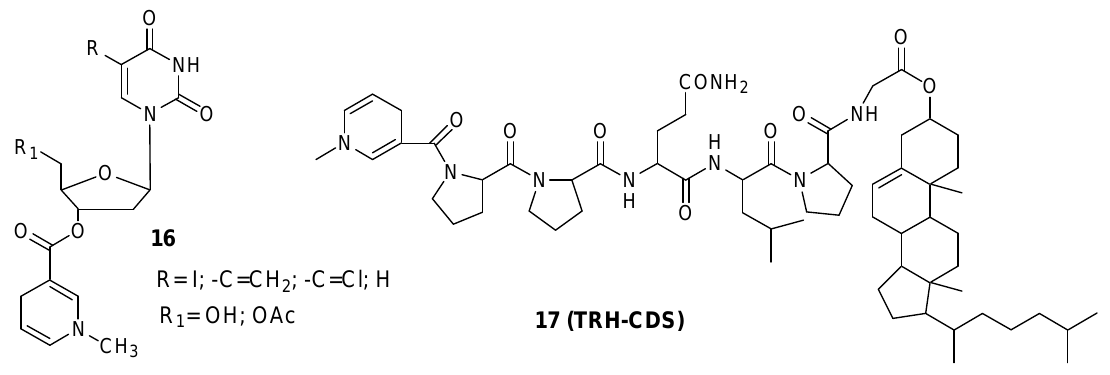
Figure 7. Pyrimidine nucleosides-CDSs and